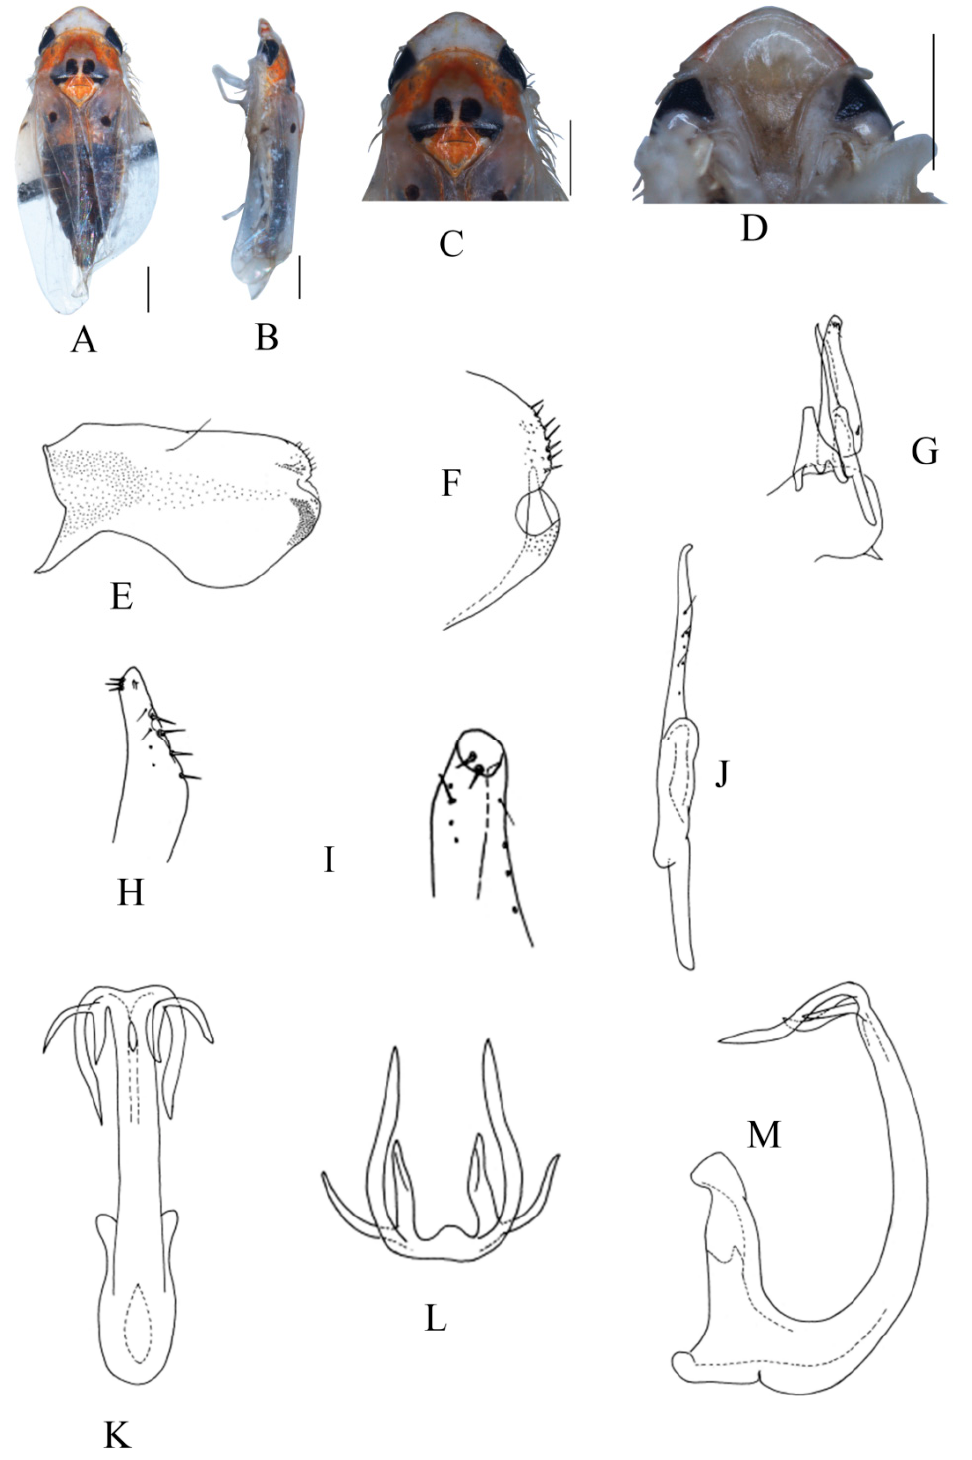
Figure 10. Eurhadina ( Singhardina ) parilintanonica sp. nov. : ( A ) habitus, dorsal view; ( B ) habitus, lateral view; ( C ) head and thorax, dorsal view; ( D ) face; ( E ) male pygofer side, lateral view; ( F ) hind part of pygofer, lateral view; ( G ) subgenital plate, connective, paramere and sternite IX, dorsal view; ( H , I ) apex of subgenital plate, dorsal view; ( J ) paramere, dorsal view; ( K ) aedeagus, posterior view; ( L ) apex of aedeagal shaft, dorsal view; and ( M ) aedeagus, lateral view. Scale bars: 0.5